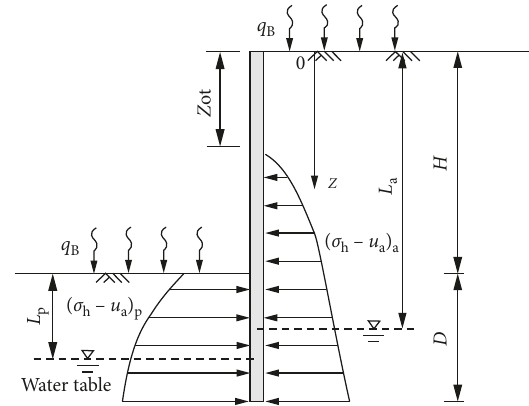
Figure 1: Computation model for deep excavation under